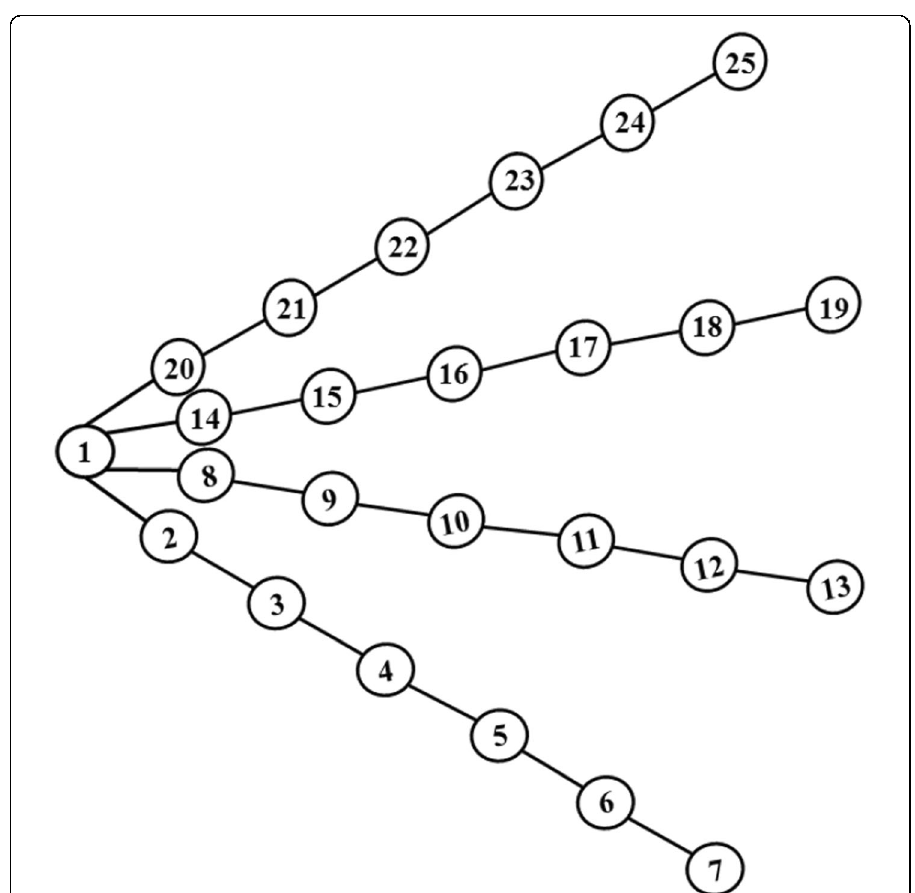
Fig. 3 A PCCL of the graph P